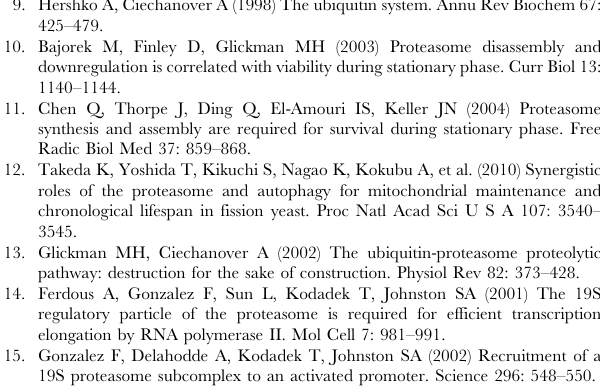
Figure S1 Growth curves and cell survival measurements of wild type, rpn11-m1 and rpn11-m5 cells expressing Rpn5-GFP. Cells were grown in YPDA medium at 26 u C during 8 days and used to monitor Rpn5-GFP localization of Figure 4. Growth curves of two independent experiments are shown in blue and red. (TIF) Figure S2 Complementation assays by the Rpn11 C-terminal domain added in trans . (A) Growth of the wild type or rpn11-m1 strains transformed with the plasmid overproducing either the Rpn11 carboxyl domain of 45 amino acids (C-R11(45)), its mutated form (C-R11-m1(25)) or the empty plasmid ( 2 ). Cells were grown in liquid minimum medium and comparable number of cells were spotted at 10-fold dilutions on YPD medium and incubated at 26 u C and 36 u C. (B) Wild type and rpn11-m1 cells expressing mtGFP and overproducing either C-R11(45), C- R11m1(25) or nothing ( 2 ) were grown to log phase in rich medium and examined by phase contrast (left) and fluorescence (right) microscopy.